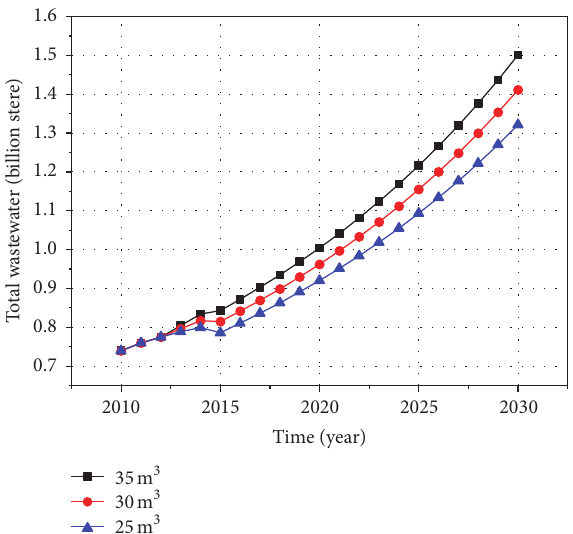
Figure 10: Total wastewater under different wastewater treatment